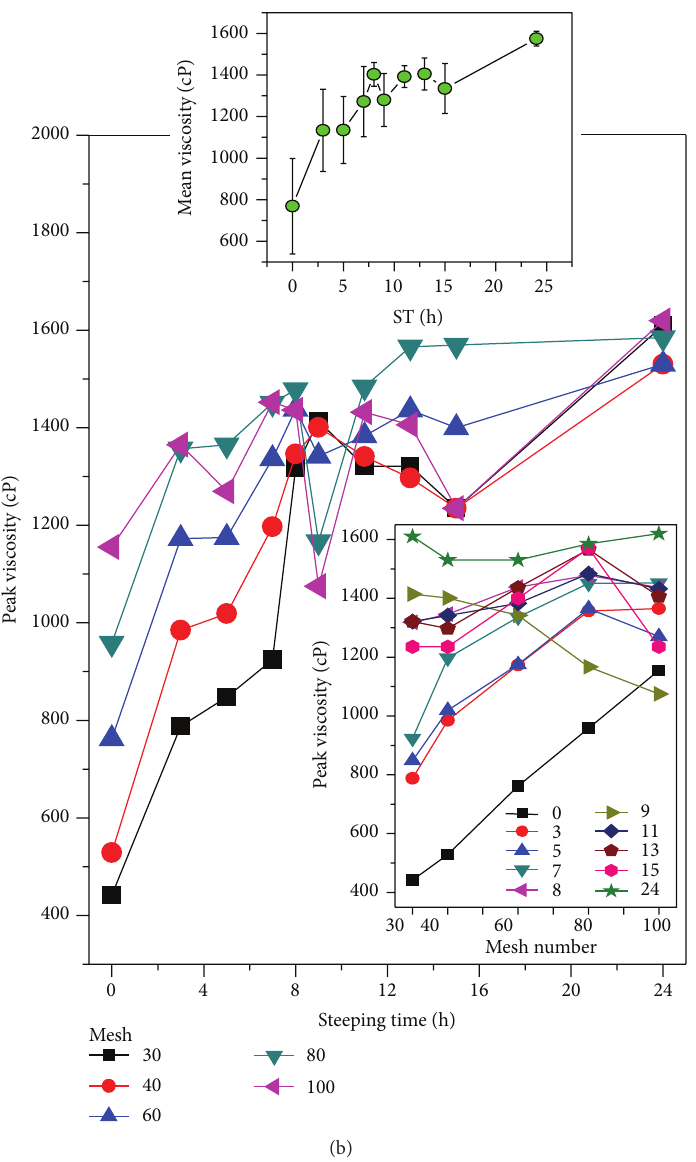
Figure 7: (a) RVA profiles of the instant corn flour for traditional nixtamalization process for samples at 𝑡 = 0, 3, 5, 7, 8, 9, 11, 13, 15, and 24 h. (b) Peak viscosity measurements at 90 ∘ C displayed as a function of ST for all the mesh numbers. The inset on bottom exhibits the peak viscosity versus the mesh numbers for the twelve ST values. The inset above shows the mean viscosity, averaged on the five mesh numbers, as a function of